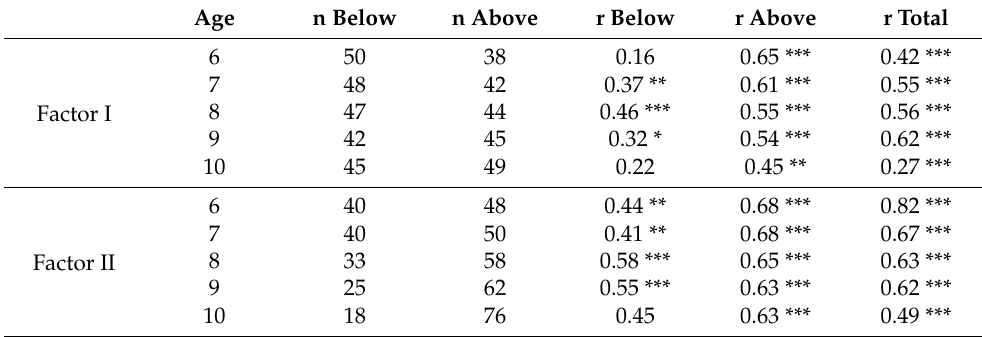
Table 7. Factor I and Factor II: correlation between RPCM scores in the standard condition and in the ZPD condition in subgroups below/above and in total